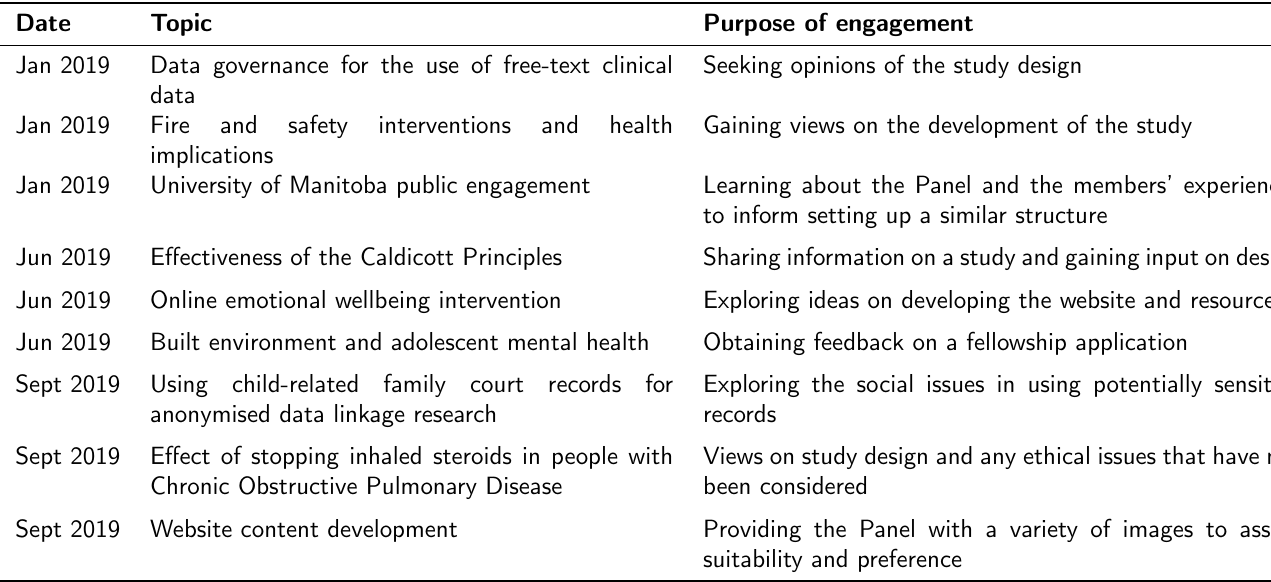
Table 1: Cont.: Topics discussed by the Consumer